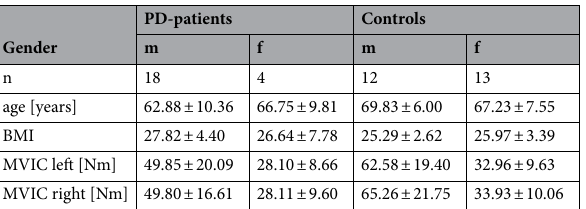
Table 1. Anthropometric data and averaged values of the maximal voluntary isometric contraction (MVIC) (arithmetic mean ± standard deviation (SD)) of all included